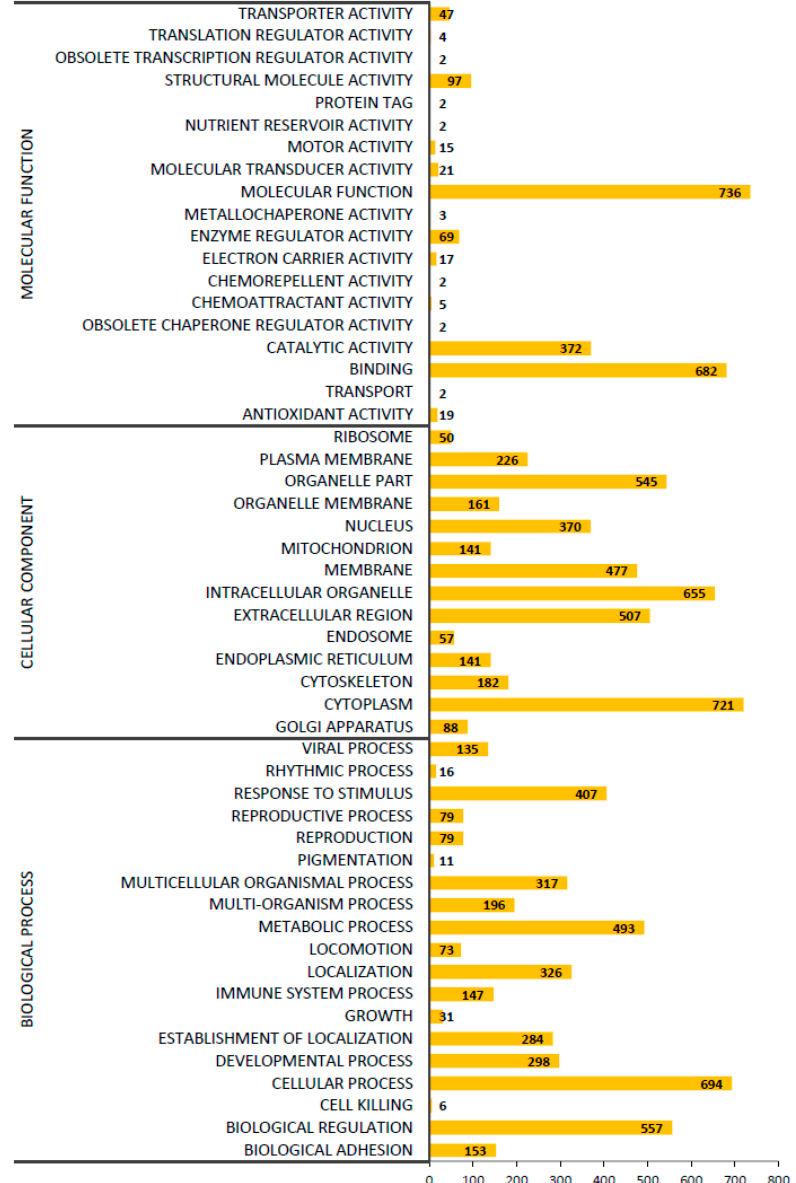
Figure 4. The biological processes, cellular components, and molecular functions of the CDM & DMEM hADSCs (as determined by the GO analysis). The ordinate indicates the biological function, cellular component, and molecular function of each protein. The abscissa indicates the number of identified proteins in the CDM & DMEM hADSCs. The names of the proteins classified in Tables S3, S5, S6, S7 and S8 are listed by their detailed biological process (growth, immune system process, biological regulation, metabolic process, and response to stimulus). The names of the proteins classified in Table S4 are listed by their detailed molecular function (antioxidant activity). n = 1.